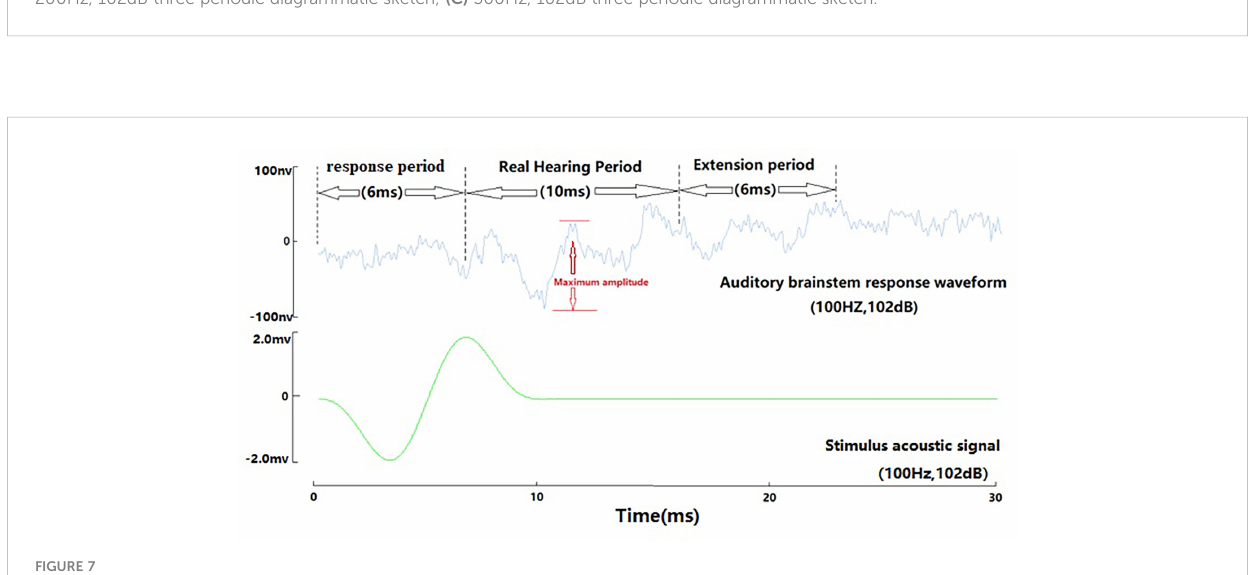
FIGURE 7 ABR three-cycle waveform of marbled rock fi sh (100Hz, 102dB).